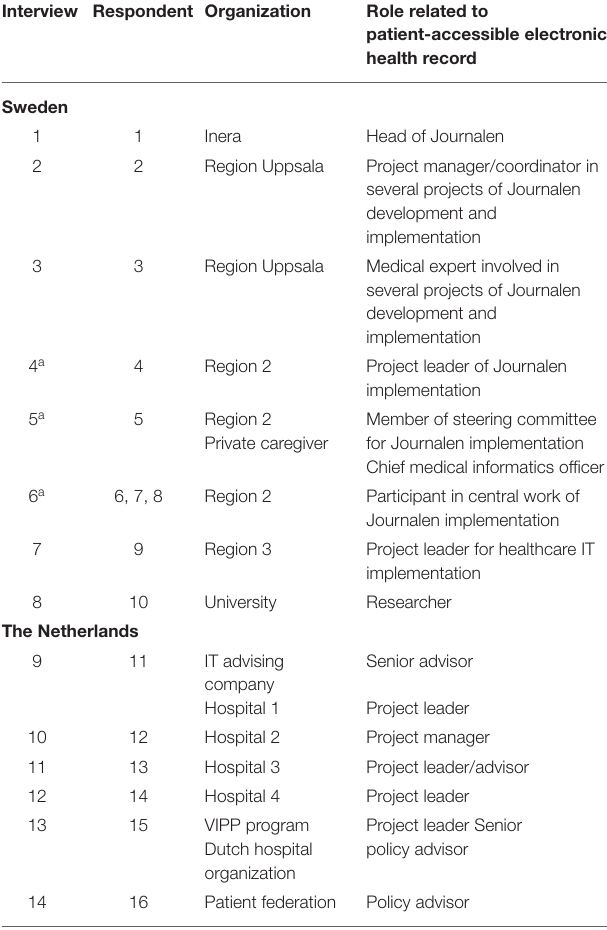
TABLE 2 | Overview of the interview